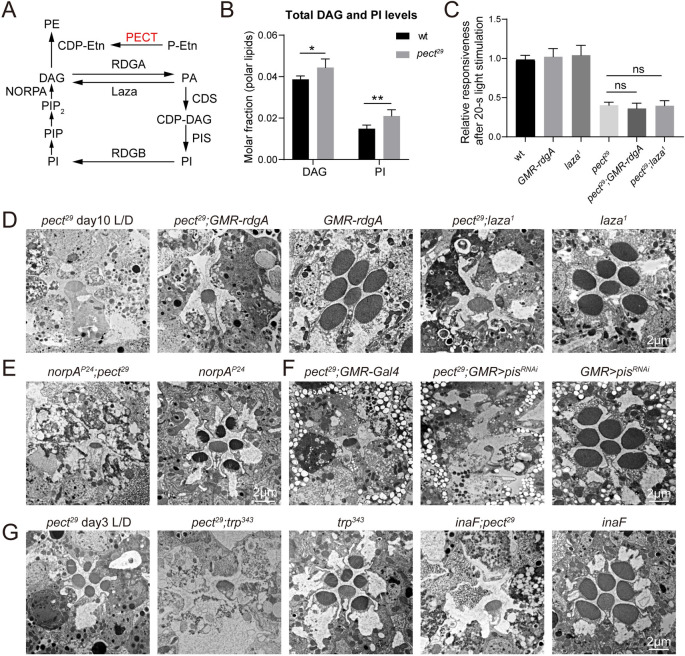
Alteration of PI and DAG levels had no effects on defective photoresponse and retinal degeneration in pect mutant flies.(A) Schematic view of the PIP2 regeneration cycle. PIP2 is hydrolyzed to IP3 and DAG through actions of NORPA. The DAG is converted into PIP2 through multistep processes that involve RDGA, CDS, and PIS. DAG can be generated by the dephosphorylation of PA through Laza. PE is synthesized from DAG and CDP-ethanolamine (CDP-Etn), and PECT is involved in the CDP-ethanolamine synthesis pathway. (B) Lipidomic analysis of retinal DAG and PI levels in genotypes indicated. Lipid levels expressed in molar fractions are normalized to total polar lipids. Data are presented as mean ± SD, *p < 0.05, **p < 0.01 (Student’s unpaired t-test). n = 6 replicates of 20 retinas per genotype. (C) Genetically reducing DAG levels did not suppress ERG defects in pect29 mutants. ERG amplitudes of wt, GMR-rdgA, laza1, pect29, pect29;GMR-rdgA (ey-flp rh1-GFP;pect29
FRT40A/GMR-hid CL FRT40A;GMR-rdgA/+), and pect29; laza1 (ey-flp rh1-GFP;pect29
FRT40A/GMR-hid CL FRT40A; laza1) at the second 1-s pulse are normalized to ERG amplitudes at the first 1-s pulse. Error bars represent SD, and significant differences were determined using the unpaired Student's t-test (n = 6, ns, not significant). (D-E) Retinal degeneration caused by mutations in pect was not altered by genetically reducing DAG levels. TEM Sections were obtained from pect29, pect29;GMR-rdgA, GMR-rdgA, pect29;laza1, laza1, 3-day-old norpAP24;pect29 (ey-flp norpAP24/Y;pect29
FRT40A/GMR-hid CL FRT40A), and 3-day-old norpAP24 Flies. All flies were raised for 10 days under 12h-light/12h-dark cycles except where indicated otherwise. Scale bars are 2 μm. (F) Blocking PI synthesis had no effects on retinal degeneration associated with pect mutants. TEM Sections were obtained from pect29;GMR-Gal4 (ey-flp rh1-GFP;pect29
FRT40A/GMR-hid CL FRT40A;longGMR-Gal4/+), pect29;GMR>pisRNAi (ey-flp rh1-GFP;pect29
FRT40A/GMR-hid CL FRT40A;longGMR-Gal4/UAS-pisRNAi), and GMR>pisRNAi (longGMR-Gal4/UAS-pisRNAi) flies. All flies were raised for 10 days under 12h-light/12h-dark cycles. The knock-down efficiency of pisRNAi was 81%. Scale bar is 2 μm. (G) Blocking TRP channels did not suppress retinal degeneration in pect mutants. Sections were obtained from pect29, pect29;trp343 (ey-flp rh1-GFP;pect29
FRT40A/GMR-hid CL FRT40A;trp343), trp343, inaF;pect29 (ey-flp inaF/Y;pect29
FRT40A/GMR-hid CL FRT40A) and inaF flies. All flies were raised for 3 days under 12h-light/12h-dark cycles. Scale bar is 2 μm.